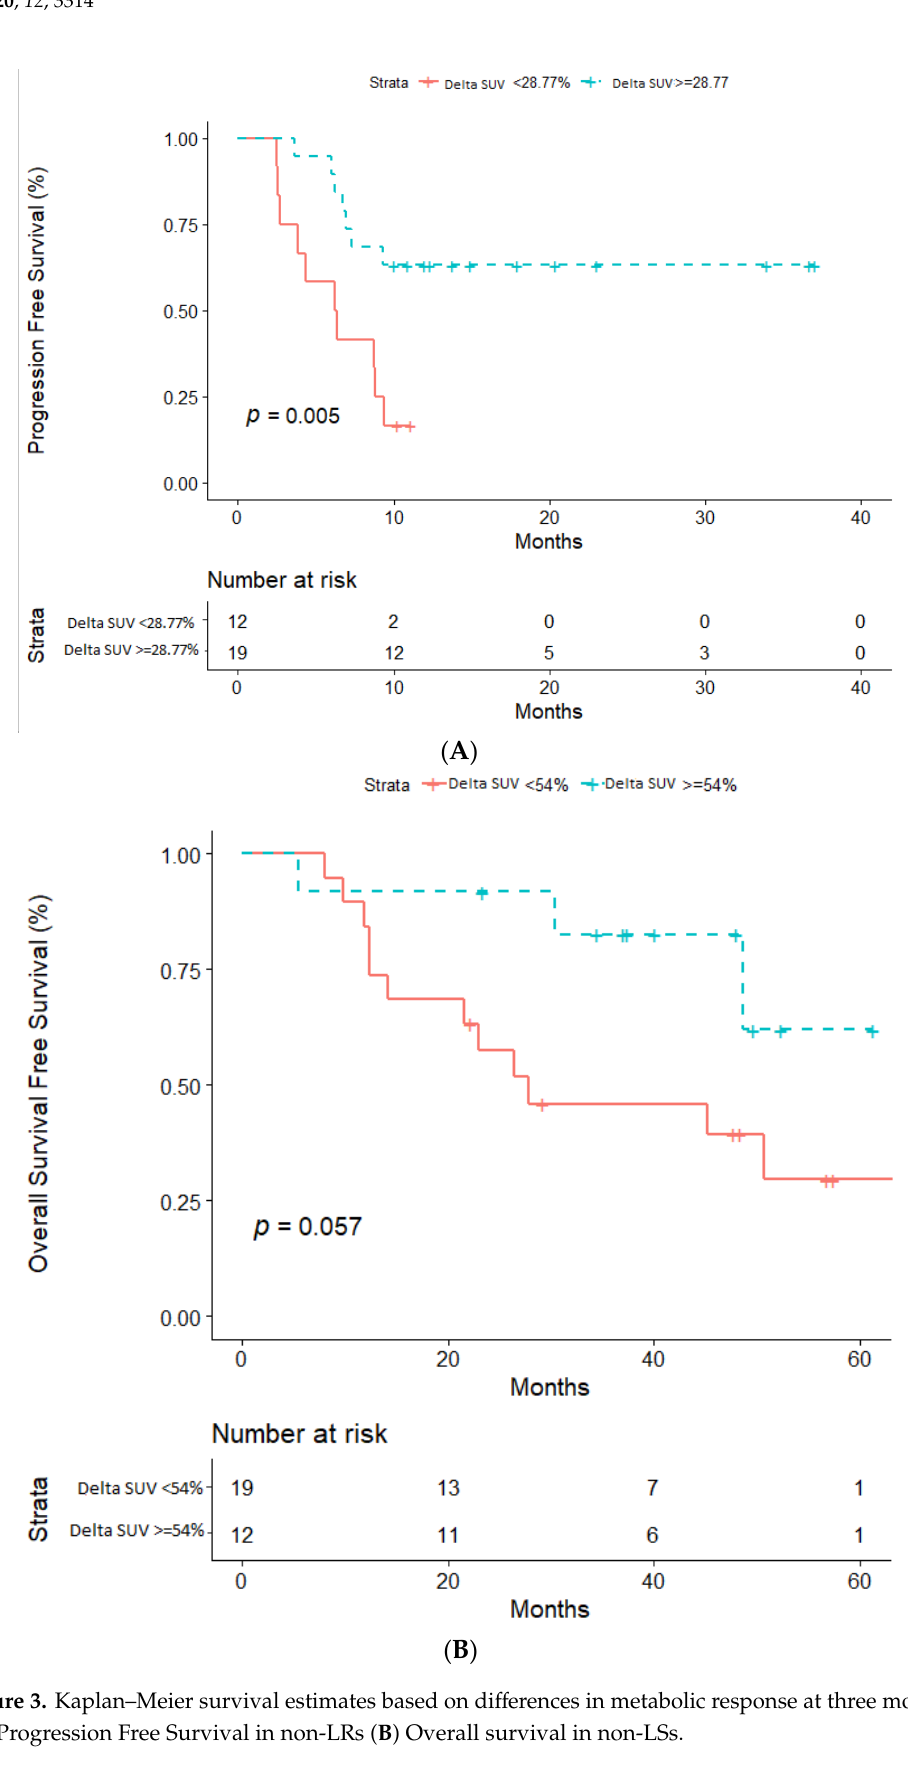
( B ) Figure 2. ( A ) Receiver-operating characteristic (ROC) analysis to differentiate LRs from non-LRs. Cut-off Δ (SUV) (%): 28.8%, area under the curve: 0.67; ( B ) ROC analysis to differentiate LSs from non-LSs. Cut-off Δ (SUV) (%): 53.8%, area under the curve: 0.62. 2.3. Impact of ΔSUV (%) on PFS and OS Based on previous analyses, patients were defined as LRs if ΔSUV (%) was higher than 28.8% (i.e., higher than 28.8% reduction of ΔSUV (%)), and as non-LRs if ΔSUV (%) was equal to or lower than 28.8% at 3-month PET scan evaluation. Using this cut-off, we identified 19(61.3%) LRs and 12(38.7%) non-LRs. Similarly, patients were defined as LSs if ΔSUV (%) was higher than 53.8% (i.e., higher than 53.8% reduction of ΔSUV (%)), and as non-LSs if ΔSUV (%) was equal to or lower than